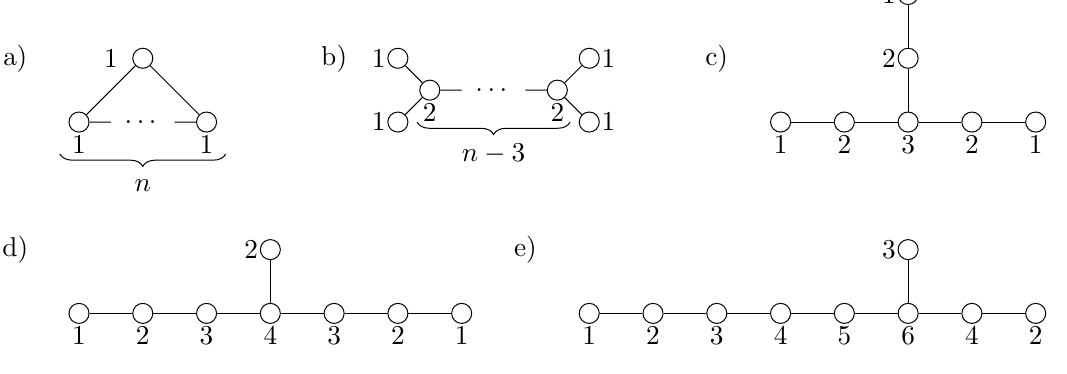
Figure 2 . Affine ADE Dynkin quivers. a) ˆ A n b) ˆ D n c) ˆ E 6 d) ˆ E 7 e) ˆ E 8 . Their Coulomb branches are the minimal nilpotent orbit closure of the corresponding algebra, written a n , d n , and e n respectively. Their Higgs branches are the Kleinian singularities corresponding to the algebra, written A n , D n , and E n respectively. It should be clear from context, when a capital letter refers to the Kleinian singularity rather than a Dynkin diagram or an algebra. The Hasse diagrams for both the Coulomb and Higgs branches are given in